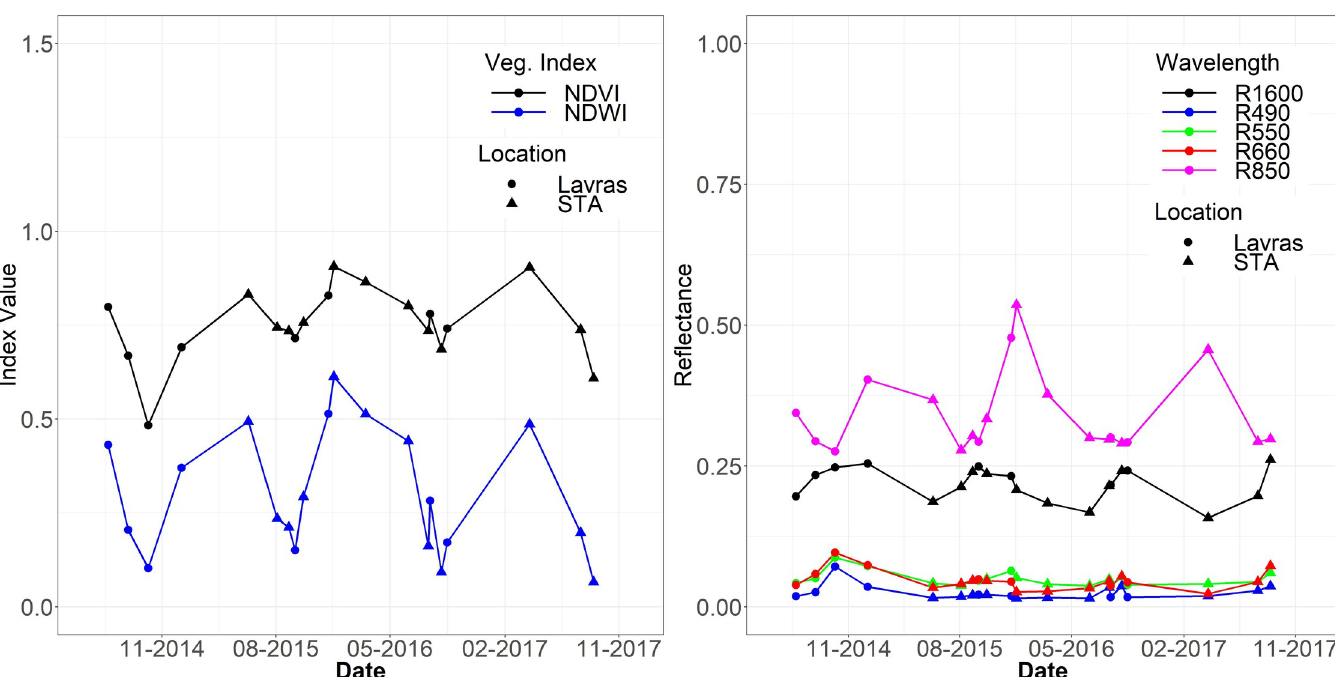
Fig 2. Temporal variability of vegetation indices (A) and surface reflectance (B) for Lavras and Santo Antoˆnio make Amparo points.